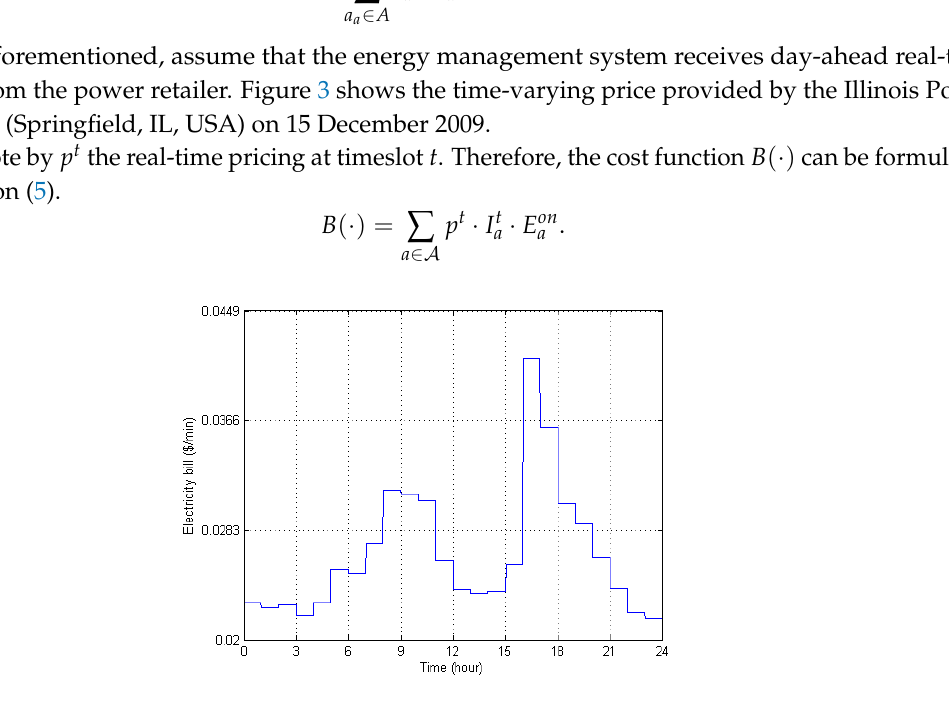
Figure 3. Example of time varying prices set by Illinois Power Company on 15 December 2009